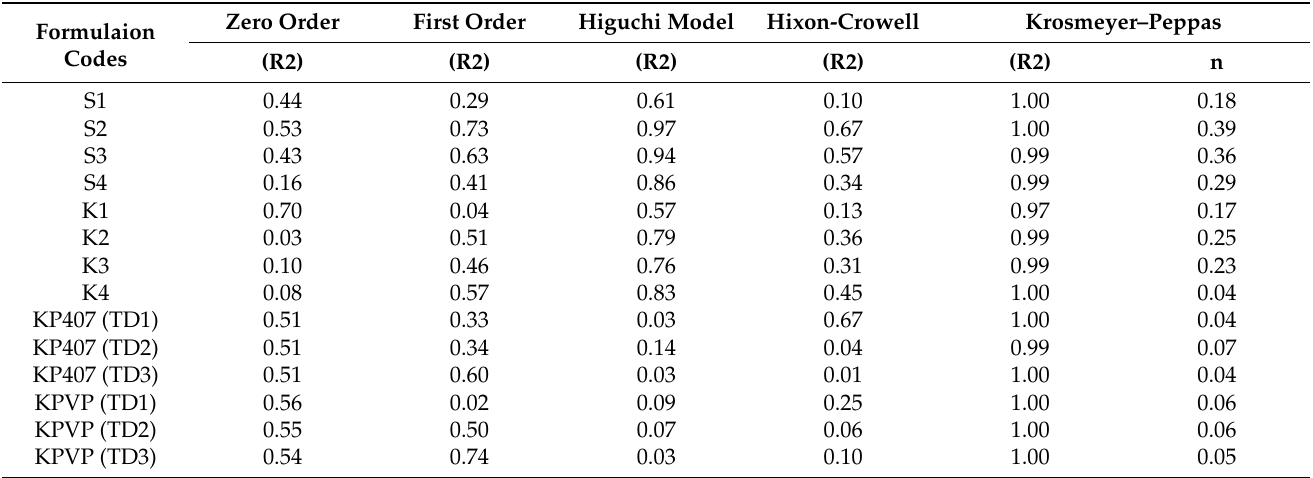
Table 5. Kinetic modelling data of prepared solid dispersion formulations from drug release in pH 6.8 phosphate buffer.